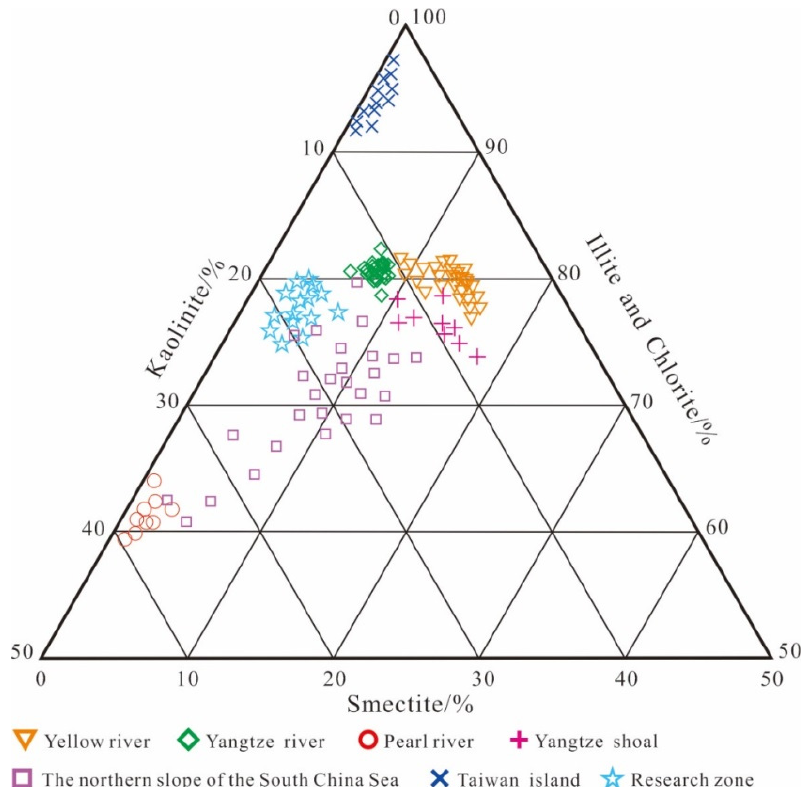
Figure 8. Diagram indicating the contents of three major clay minerals in the sampled sediments.